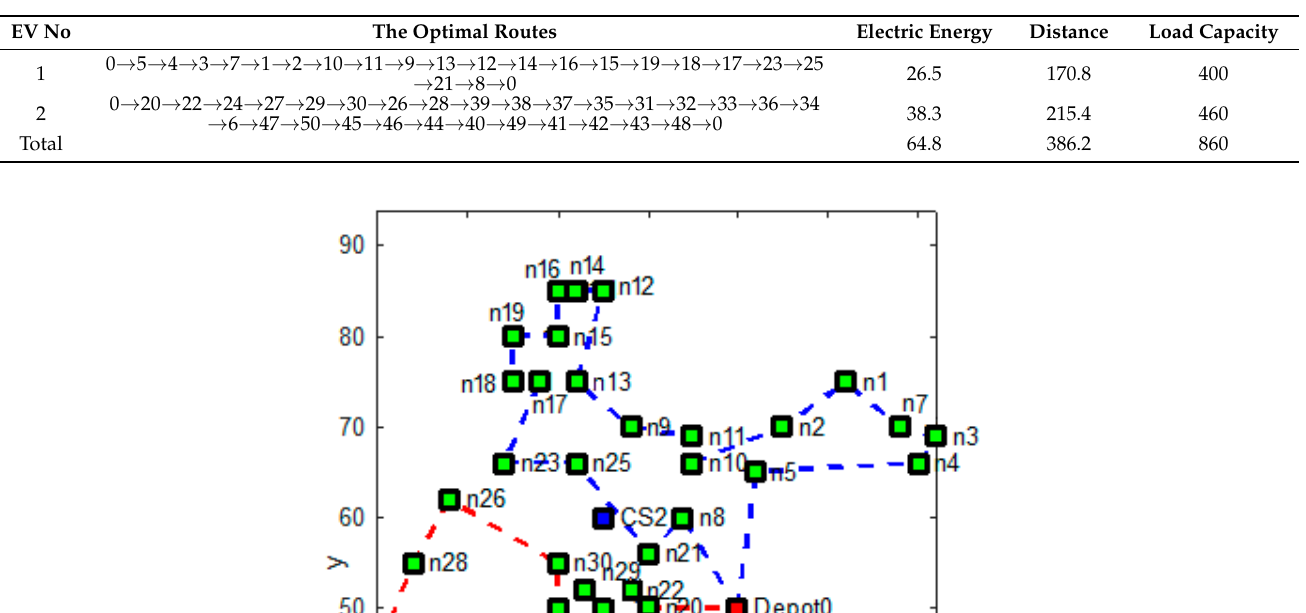
Table 6. The optimal routs on C205.50 data.